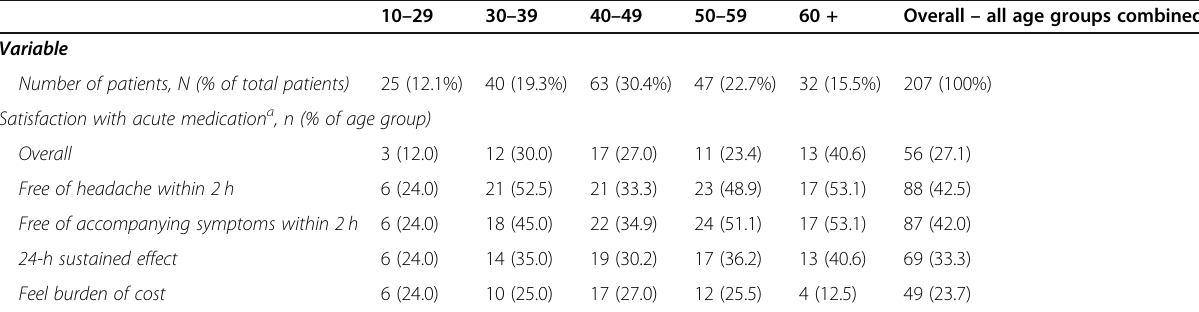
Table 3 Past experience with acute medication for